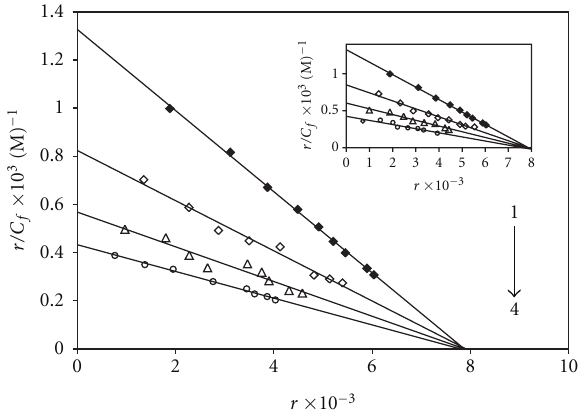
Figure 11: Competition between [Pt(bpy)(Oct-dtc)]NO 3 and the inset for [Pd(bpy)(Oct-dtc)]NO 3 with ethidium bromide for the binding sites of DNA (Scatchard plot). In curve no. 1, Scatchard plot was obtained with calf thymus DNA alone. Its concentration was 60 μ M. In curves nos. 2, 3, and 4, respectively, 33 μ M, 71 μ M, and 111 μ M for Pt(II) complex and 12 μ M, 35 μ M, and 55 μ M, for Pd(II) complex were added, corresponding to molar ratio [complex]/[DNA] of 0.55, 1.18, and 1.85 for Pt(II) complex and 0.2, 0.58, and 0.92 for Pd(II) complex. Solutions were in 20 mM NaCl and 20mM Tris-HCl (pH 7.0). Experiments were done at room